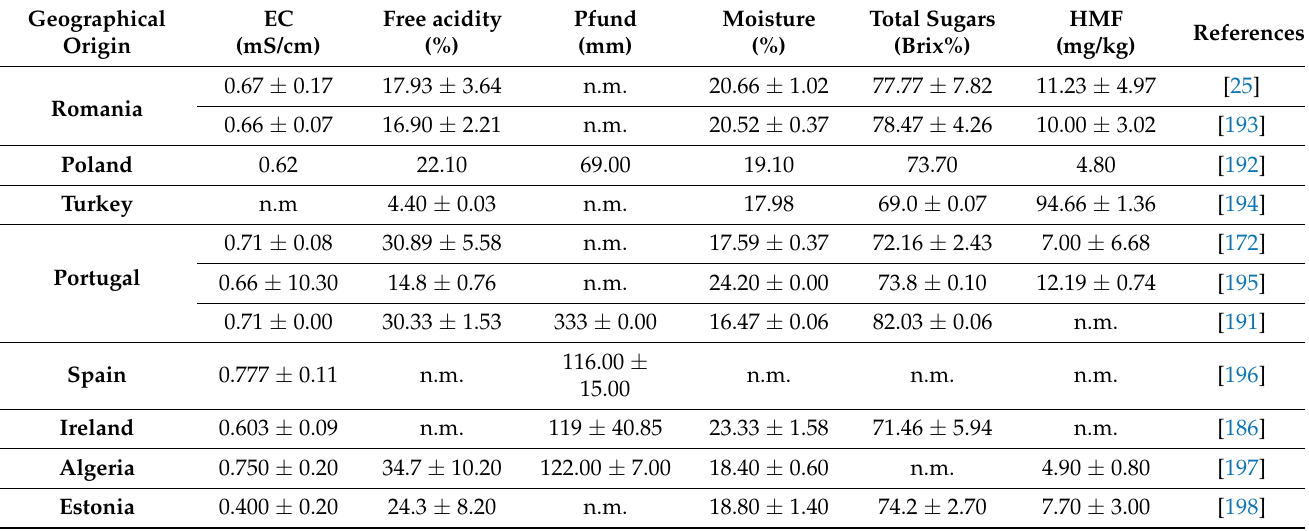
Table 4. Physicochemical characteristics of heather honey from different geographical